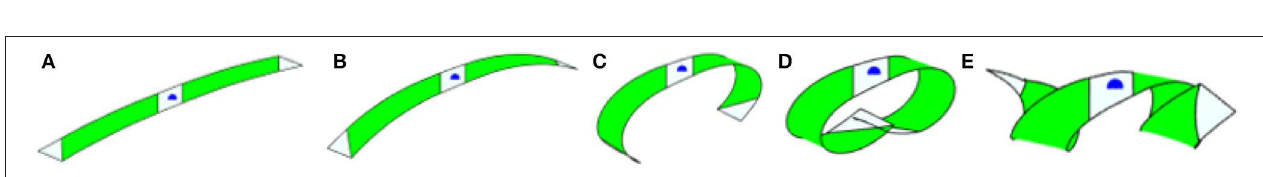
FIGURE 13 | Gaussian curvature of folded disk shape plate. Left: with large electric field increment; Right: with small electric field increment. (A) Electric field 11 MV/m; (B) electric field 17 MV/m; and (C) electric field 19 MV/m.